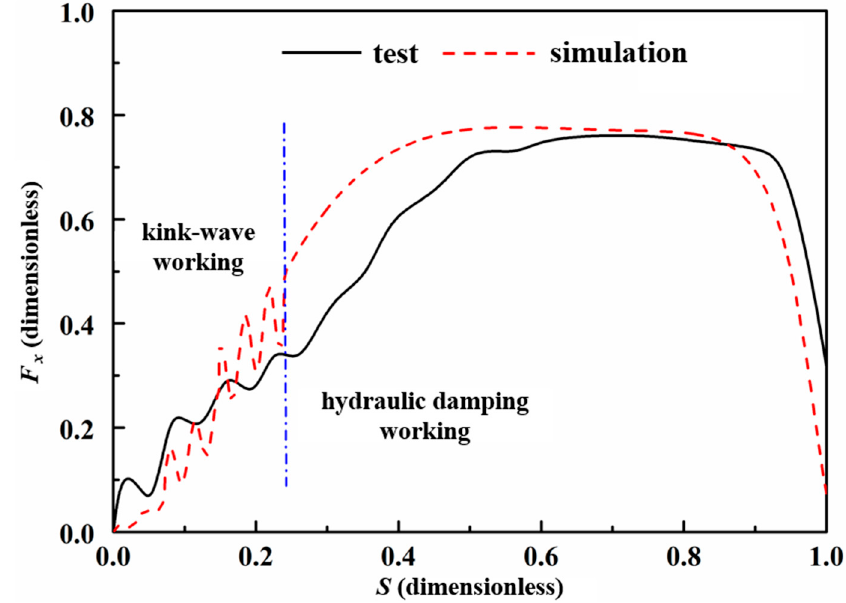
Figure 9. Curves comparison of arresting force–displacement in simulation and test.